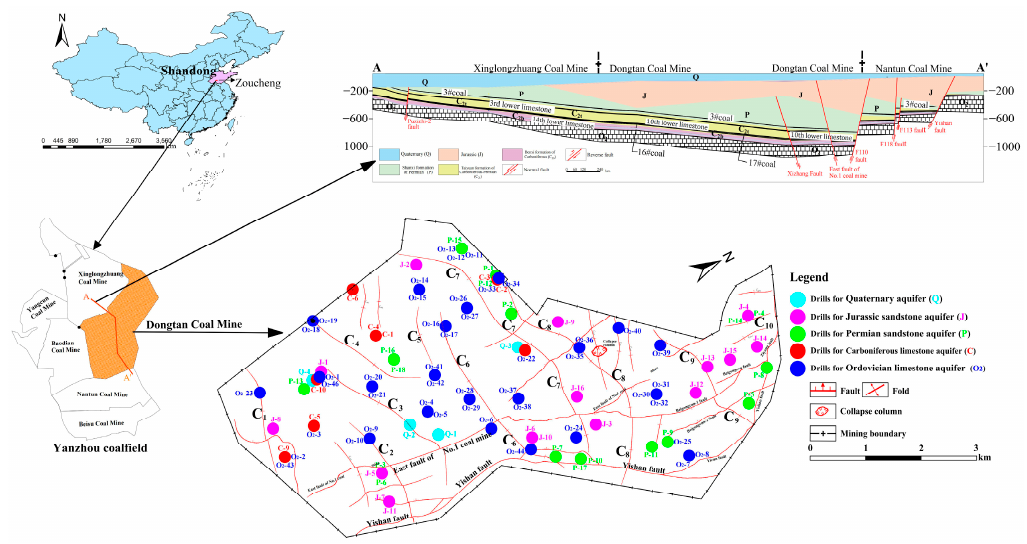
Figure 1. Map of the study area and water sample locations (A-A (cid:48) is geological cross section of the Yanzhou coal